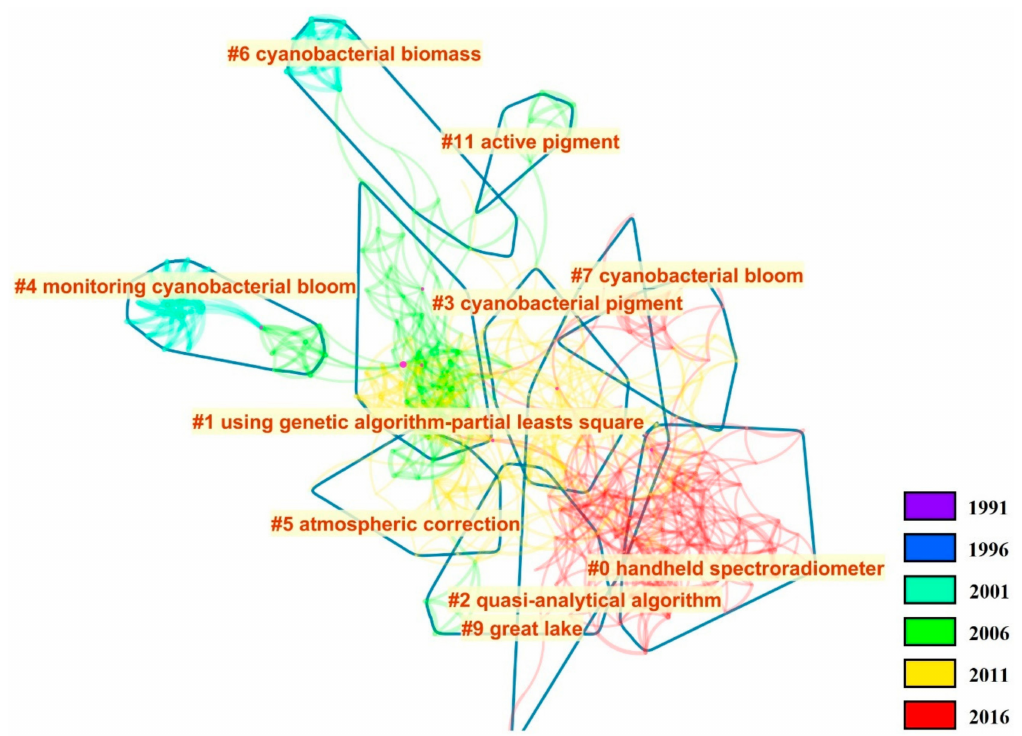
Figure 3. The co-citation network of remote sensing of PC publications clusters (1991–2020) and clusters’ labels extracted by the LLR